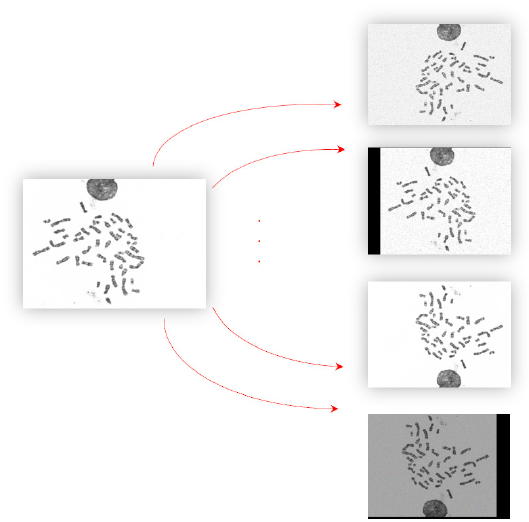
Figure 6. Schematic diagram of data augmentation to generate new